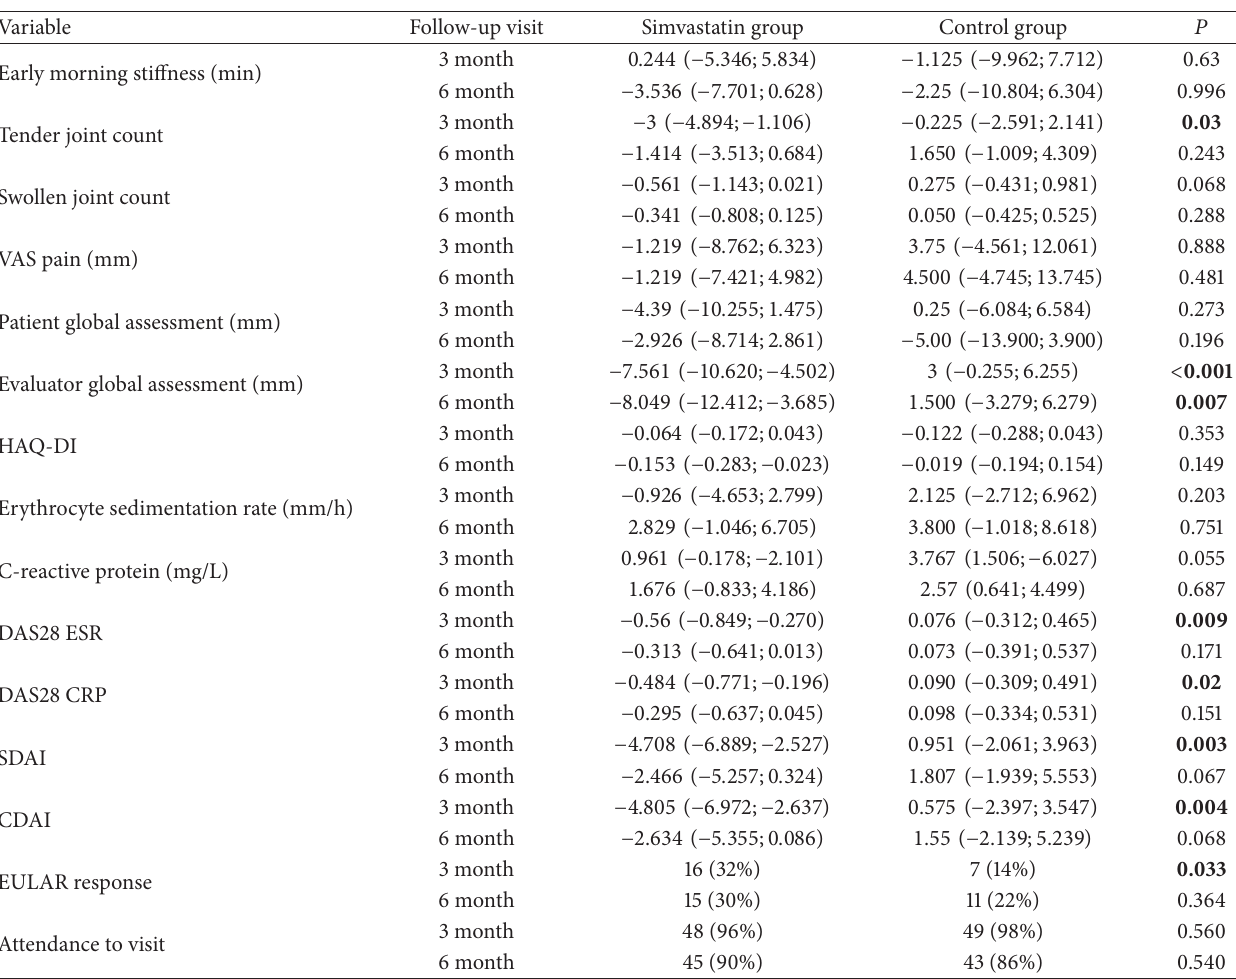
Table 2: Differences after 3 and 6 months of treatment.